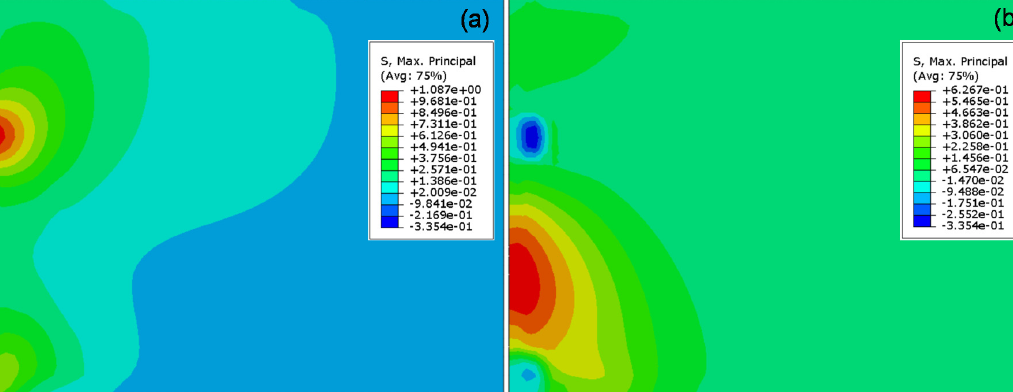
Figure 12. ( a ) Variation in stress of the slab with position of load; and ( b ) Stress nephogram of slab bottom under loading at position.